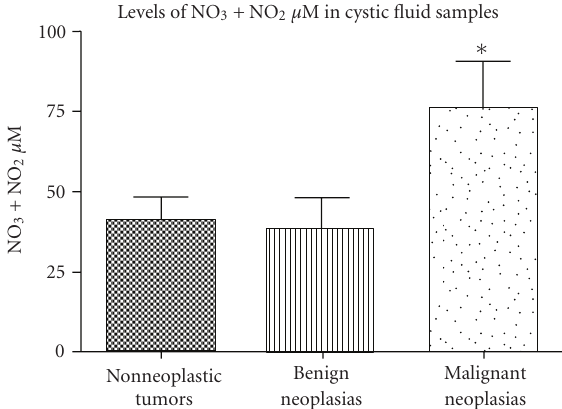
Figure 3: NO metabolite levels determined from cystic fluid samples obtained from patients with nonneoplastic tumors ( n = 14), benign tumors ( n = 27), and malignant neoplasias ( n =